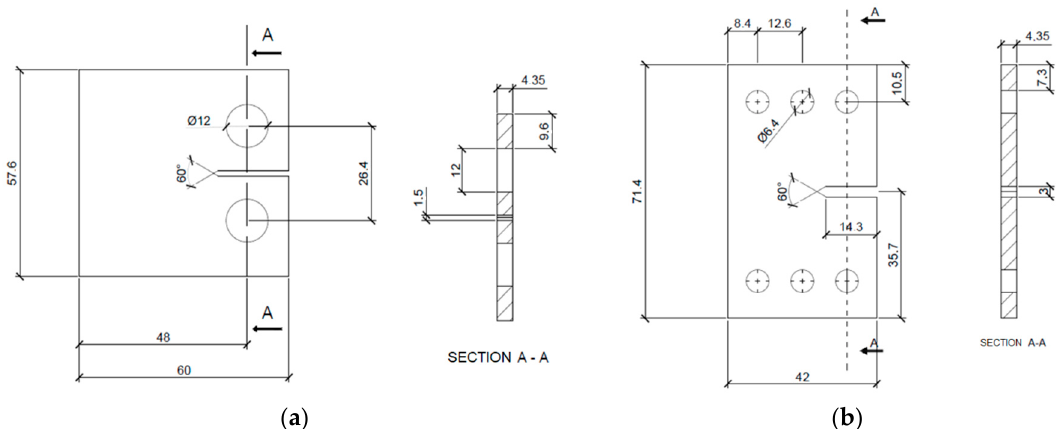
Figure 4. FCGR (Fatigue Crack Growth Rate) test specimens. ( a ) CT (Compact Tension) specimen scheme and dimensions (in mm) for mode I test; ( b ) CTS (Compact Tension Shear) specimen scheme and dimensions (in mm) for mixed mode I + II test.